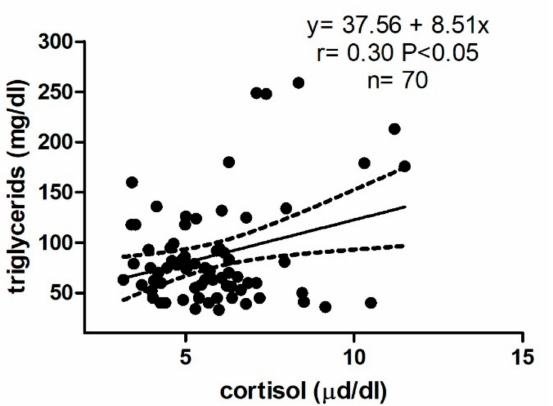
Figure 2. Linear regression model results obtained between serum cortisol and serum triglycerides in Group B (barren